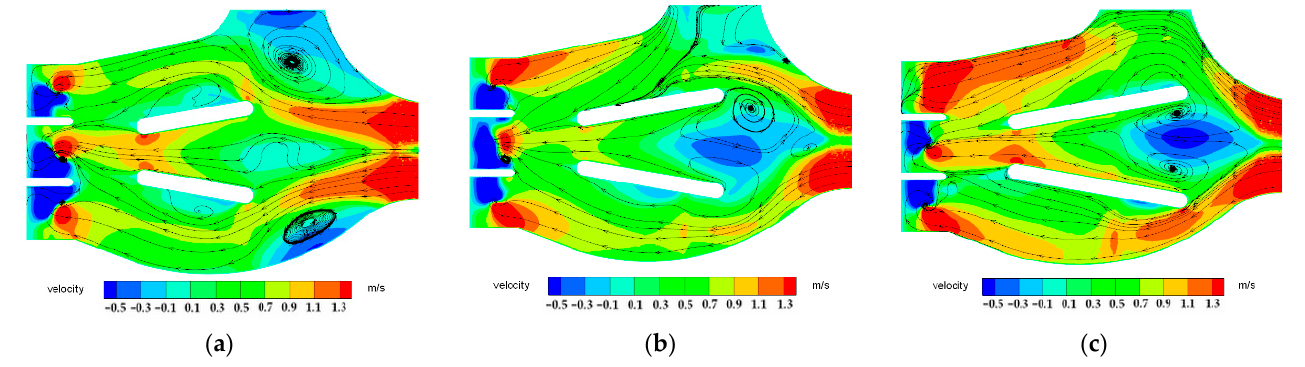
Figure 13. Comparison of bottom streamline and velocity cloud images at different angles. ( a ) 0.3 L, ( b ) 0.4 L, and ( c ) 0.5 L .